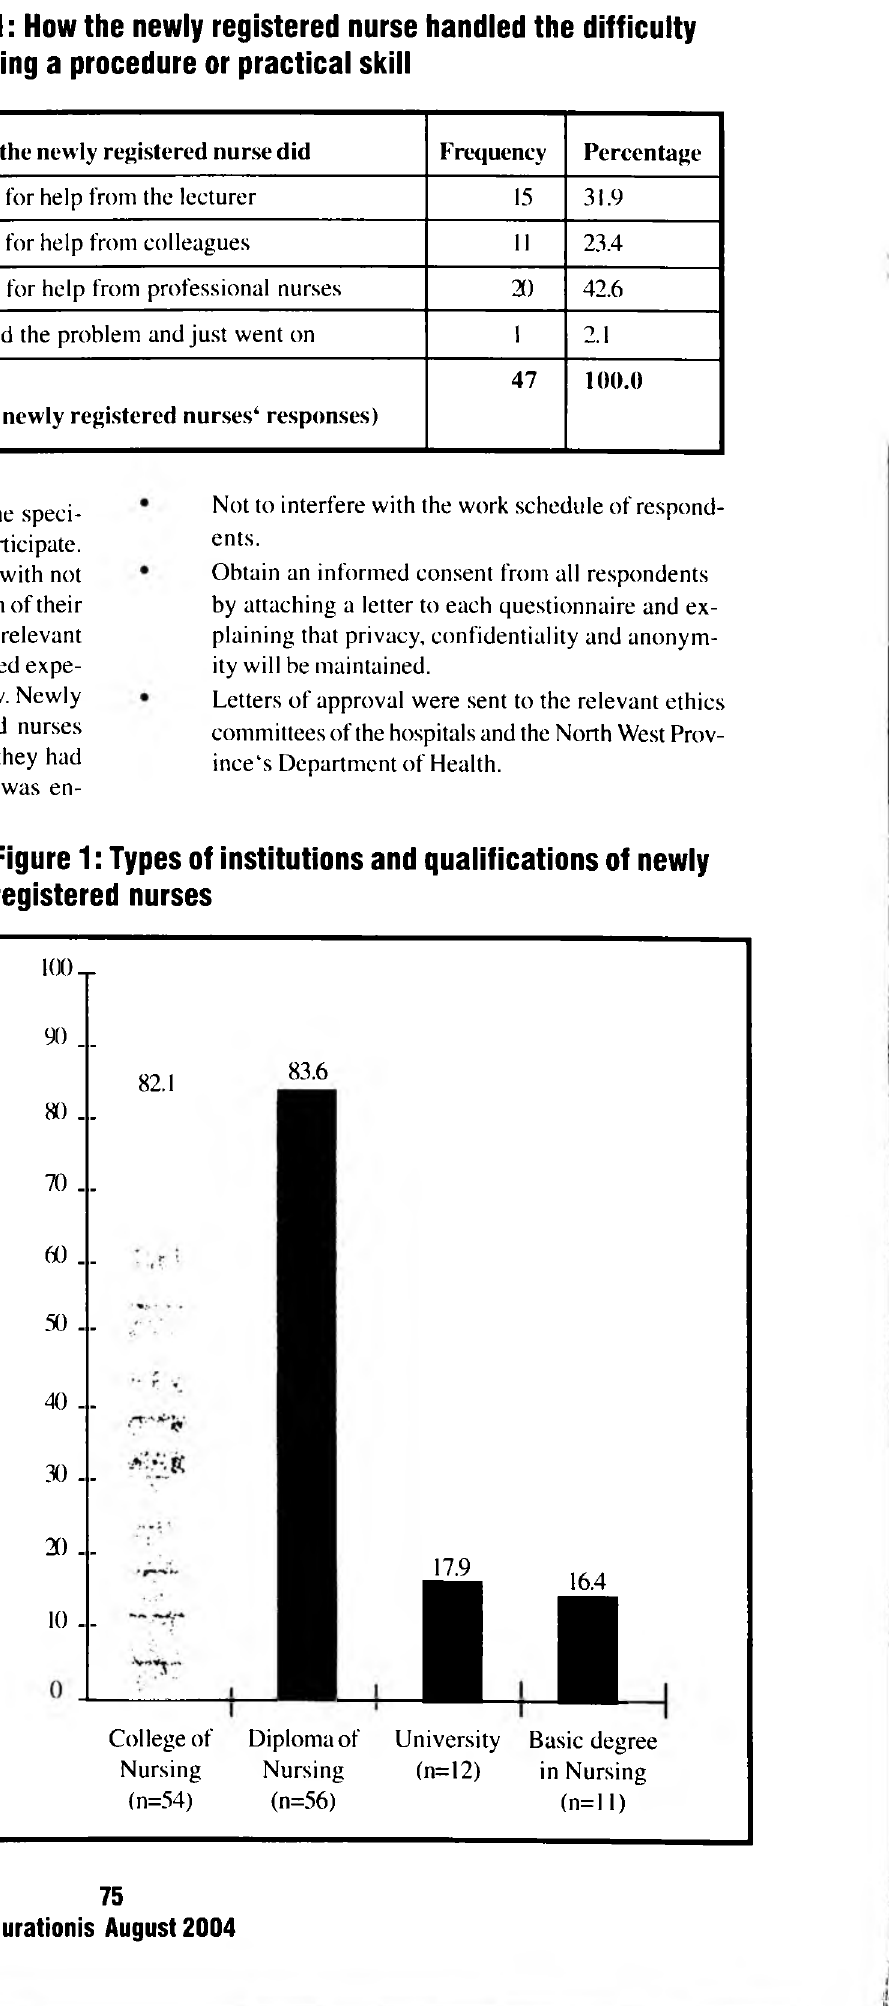
Table 1: How the newly registered nurse handled the